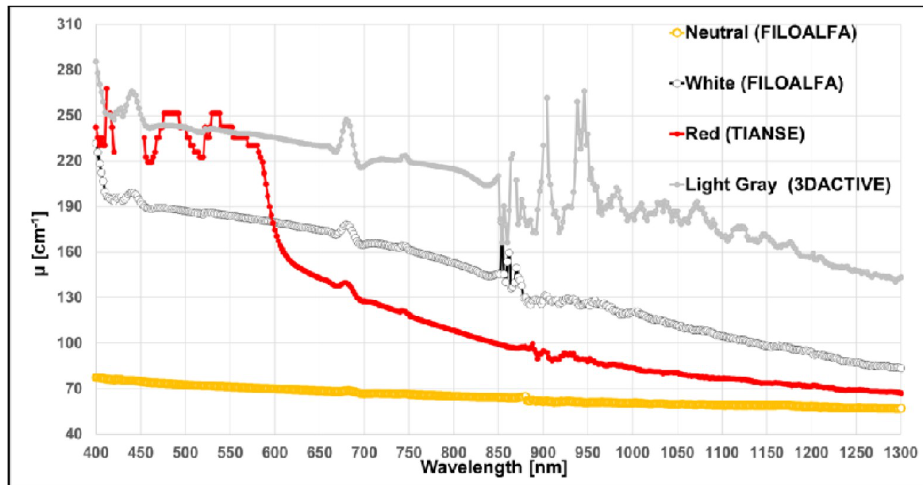
Fig 4. Extinction coefficient μ spectra in the wavelength range 400–1300 nm for PLA filaments with different colors from diverse producers.